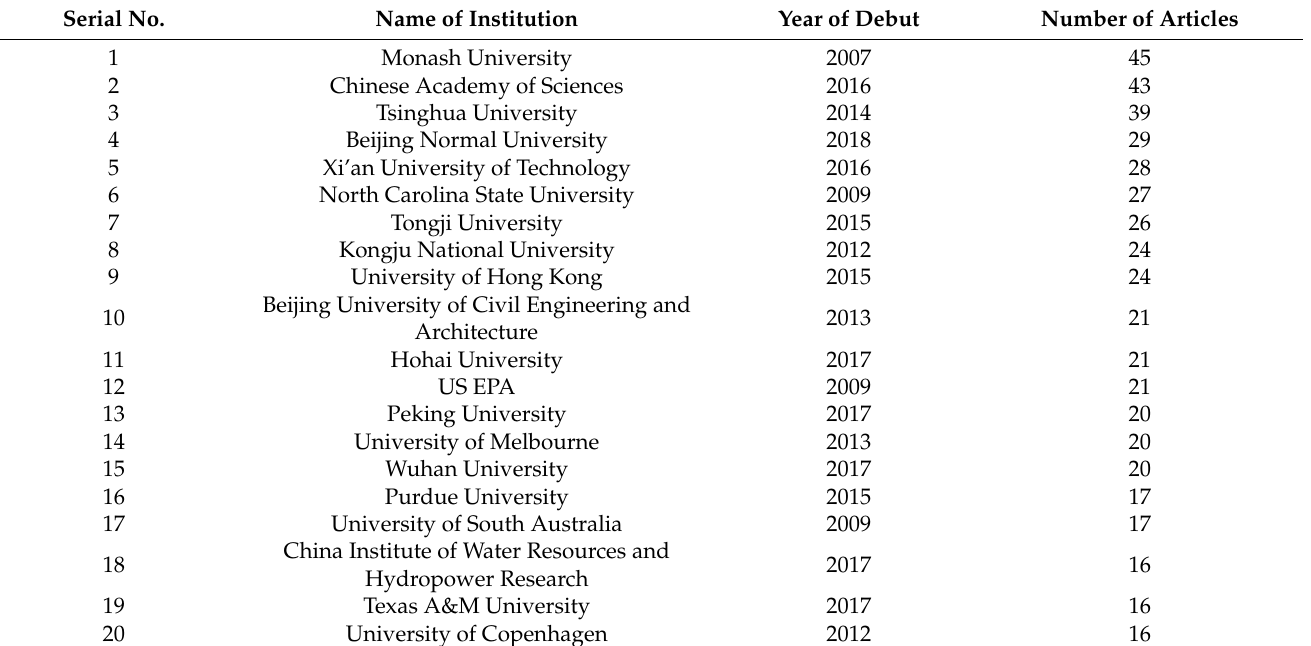
Figure 7. Chronological chart of international research institutions. Table 1. Top 20 research institutions.